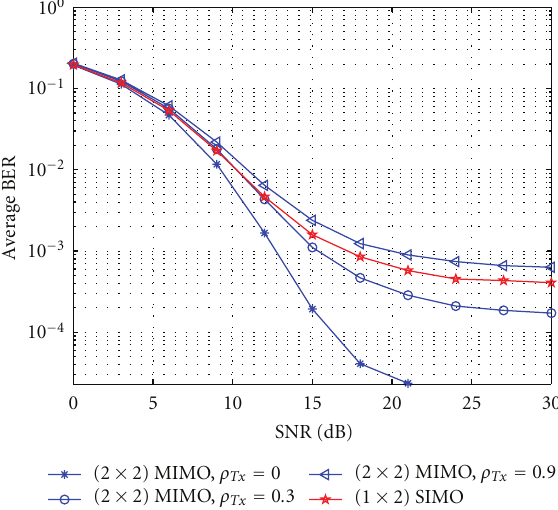
Figure 8: BER performance of 2 × 2 MIMO and 1 × 2 SIMO systems, for CM2